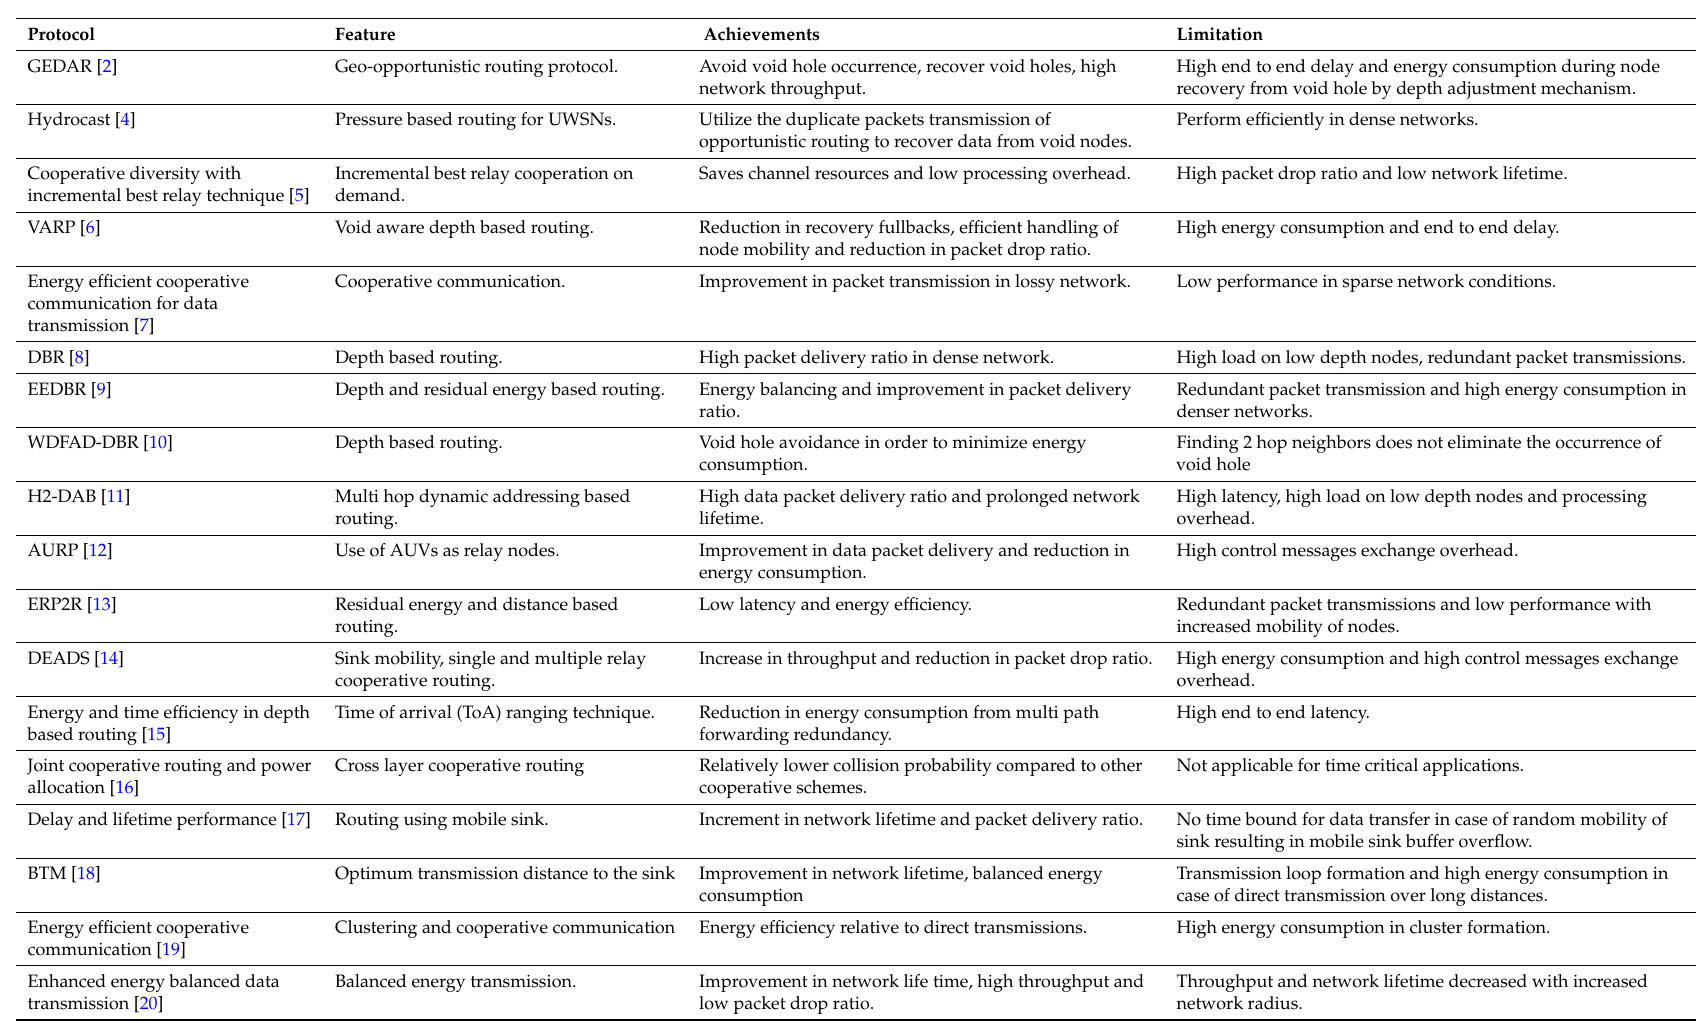
Table 1. State of the art related